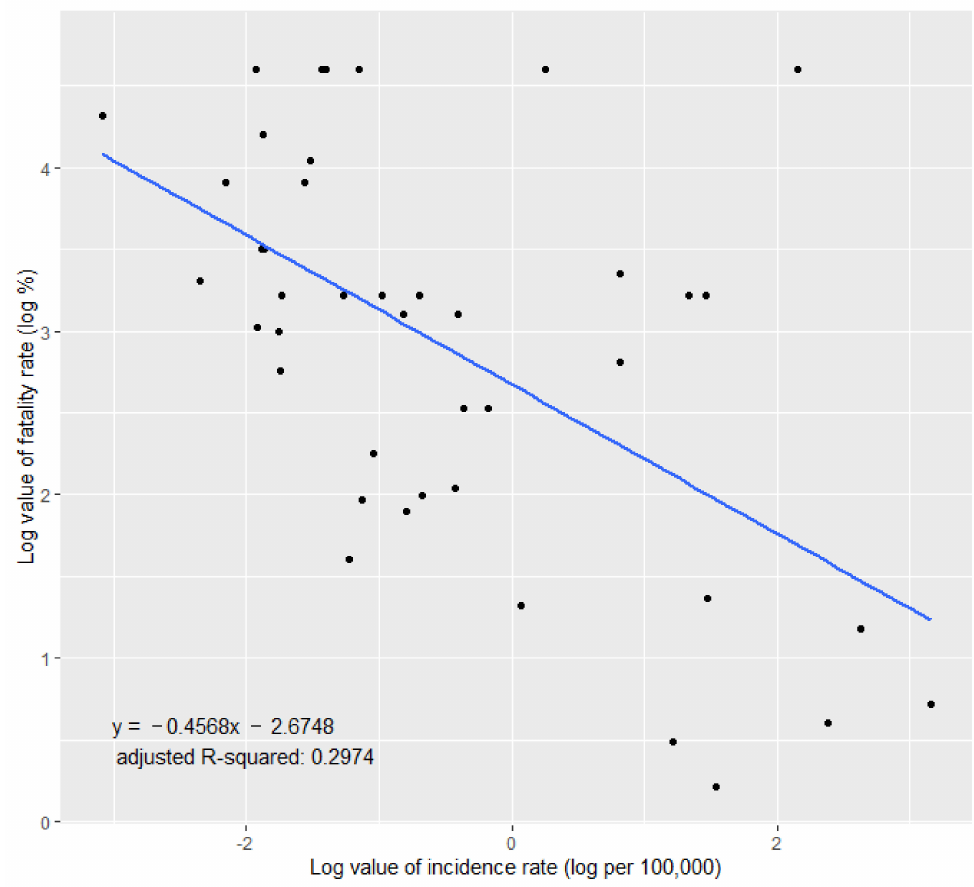
Figure 7. The relationship between the logarithmic value of the incidence rate and fatality rate. Groups 4 and 5, which are groups with high incidence rates, consisted of many in- dustries that are known to involve biological risks, some of which are legally